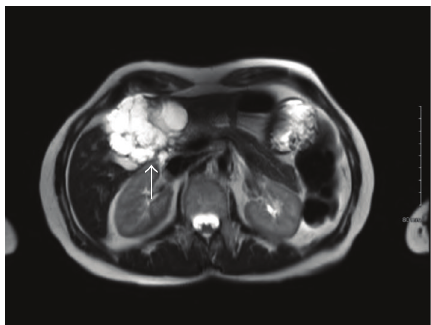
Figure 1: MRI image detailing a 6.6 × 5 cm cystic mass originating from segment 4B of the liver (arrow).